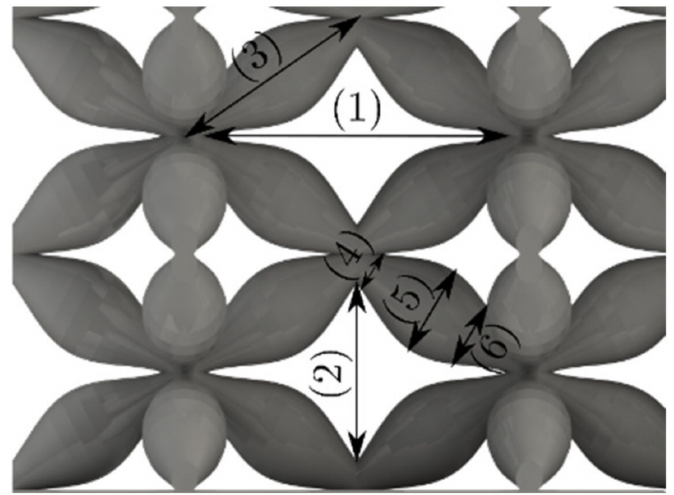
Figure 7. Six measurements were used to track variation between CAD and 3D printed